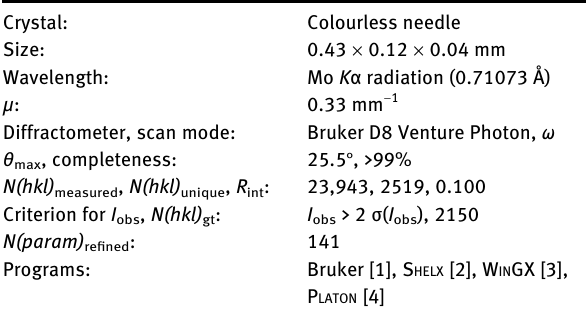
Table  : Data collection and handling.